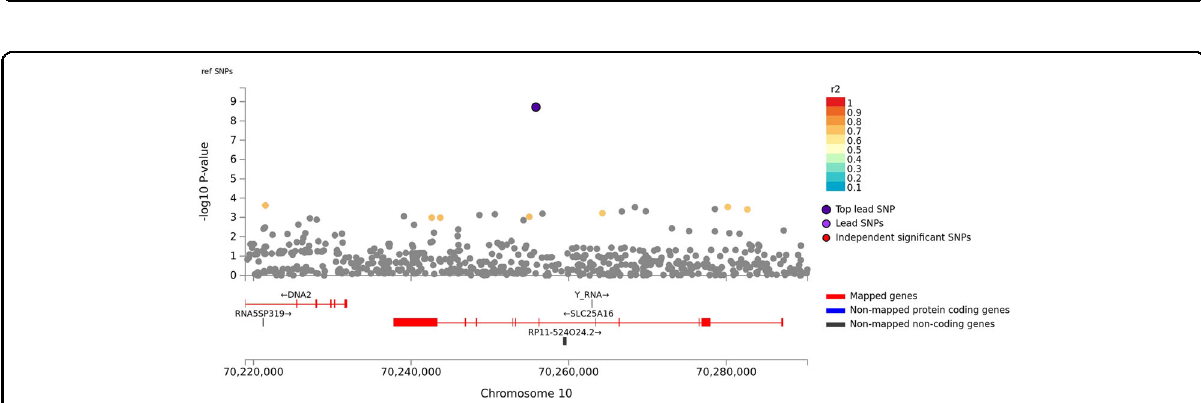
Fig. 2 Association of stimulant dependence with SNPs located in the SLC25A16 region in the African American discovery sample. SNPs are color-coded according to the correlation coef fi cient ( r 2 ) in the 1000 Genomes African reference panel with the top-ranked SNP, rs2394476. Rs2394476 was genome-wide signi fi cant ( P = 1.22 × 10 − 9 ) after meta-analysis with the replication sample.